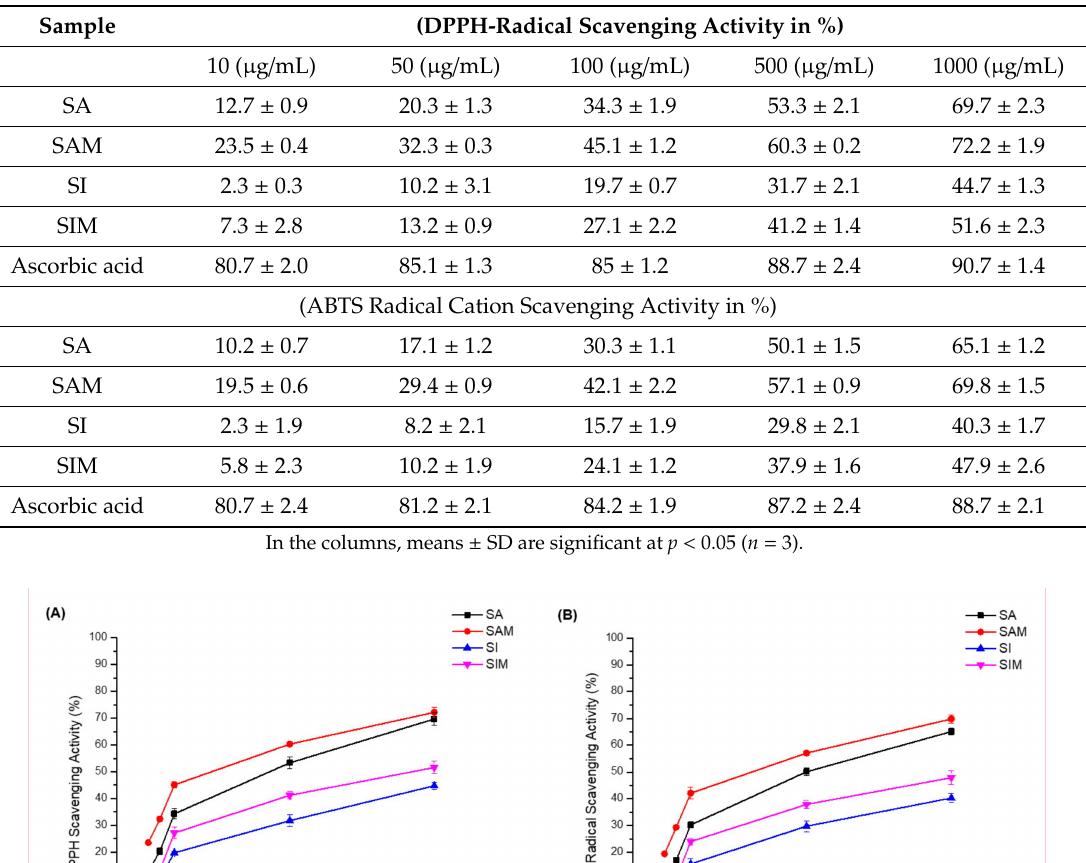
Table 2. DPPH and ABTS scavenging activities of SA, SAM, SI, and SIM.